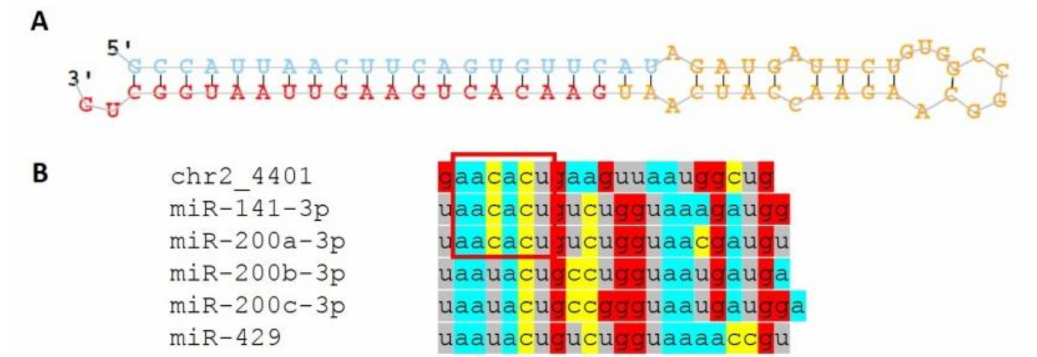
Figure 4. ( A ) Hairpin structure of the novel miRNA chr2_4401 precursor predicted by miRDeep2. ( B ) Sequence alignment between chr2_4401 and five miR-200 family miRNAs. The seed region (nucleotides 2–7, red square) of chr2_4401 is identical with miR-141-3p and